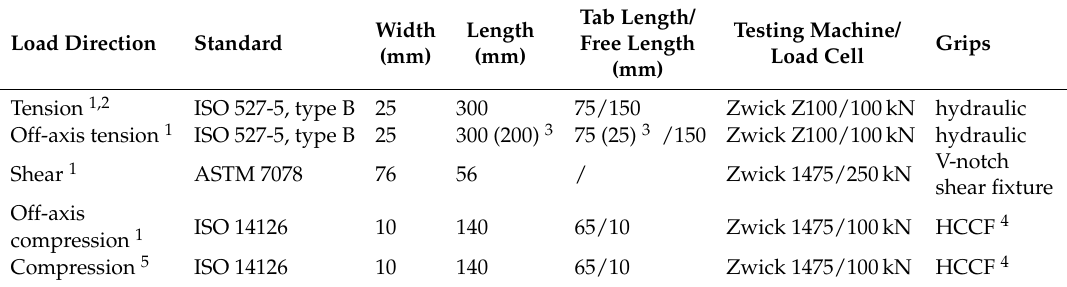
Table 6. Standards and specimen dimensions for material testing in transverse fiber direction of reference samples, samples with gaps and fiber shearing